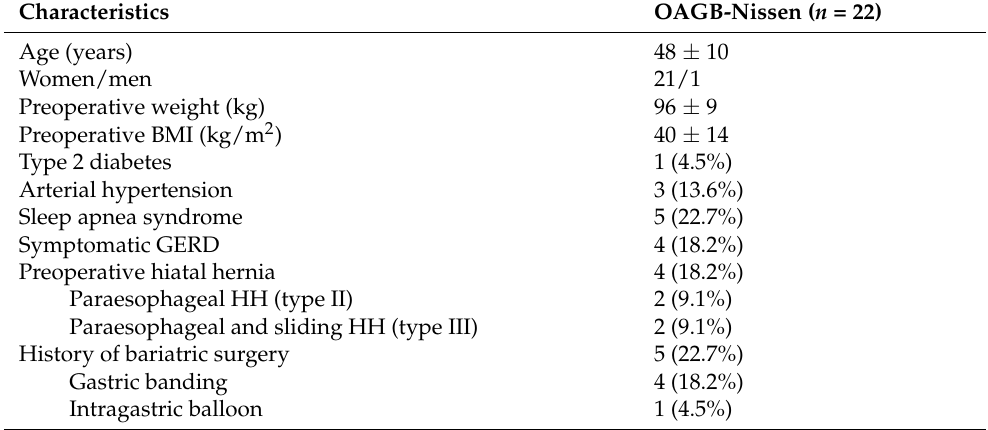
Table 1. Clinical characteristics of the patients.